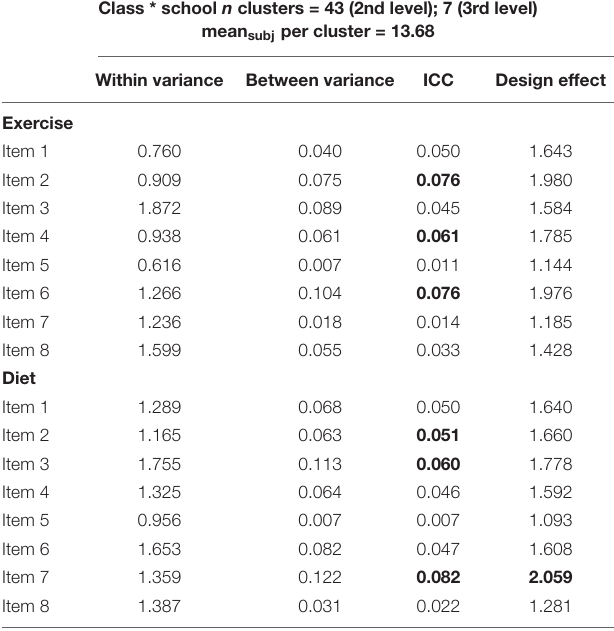
TABLE 1 | Items’ multilevel properties: within and between variance, ICC, and design